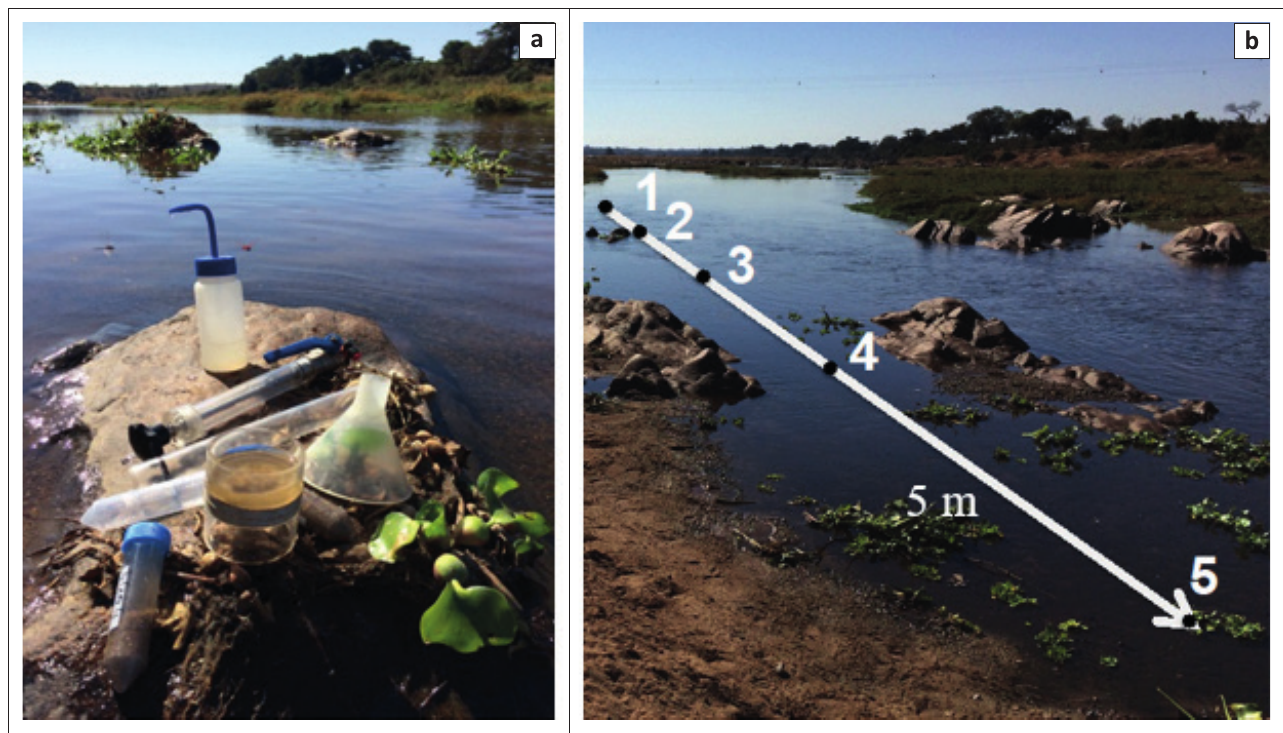
FIGURE 3-A1: (a) material used to sample meiobenthos: brush-sampler to scrape stones and cobbles underwater, perspex corer to sample sediment, sieve, funnel and tubes. (b) Localisation of sampling plots along a reach of the Crocodile River. The downstream plot (#1) was sampled first.